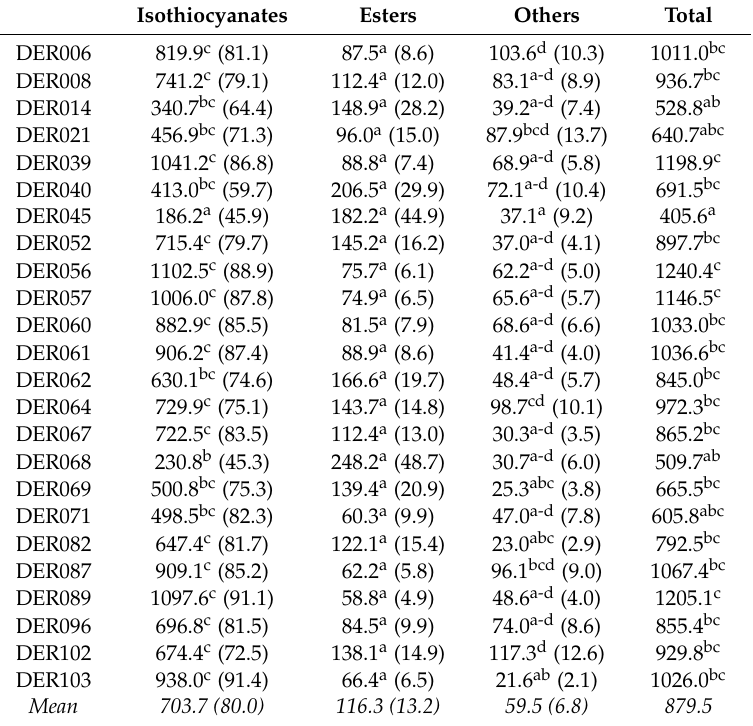
Table 2. Absolute levels (GC-peak area units, × 10 6 ) for the groups of volatile organic compounds identified in the wall rocket materials ( n = 3). The relative abundances (%, in parentheses) are also